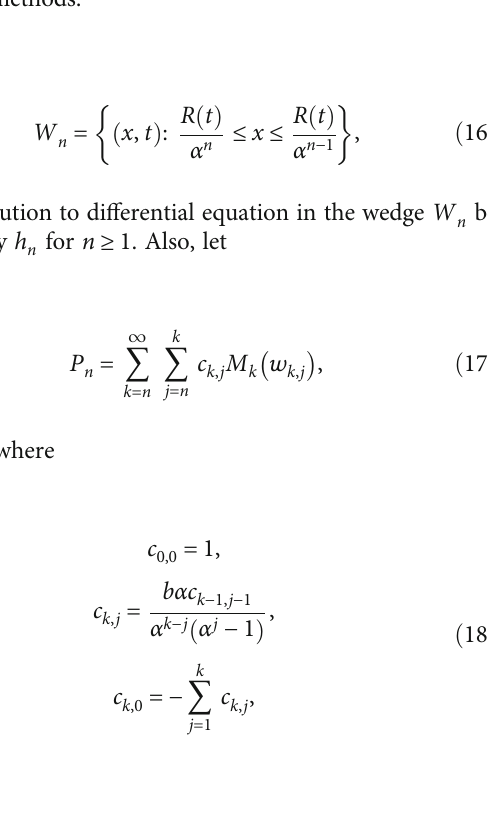
Figure 2: The construction of wedges for the case r ð t Þ = 1/1 + t and α = 2